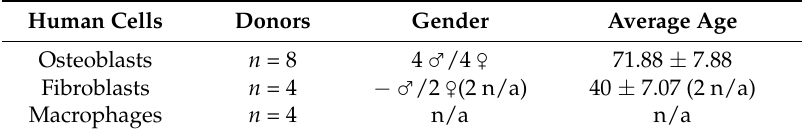
Table 2. Characteristics of the human cell donors used for cell